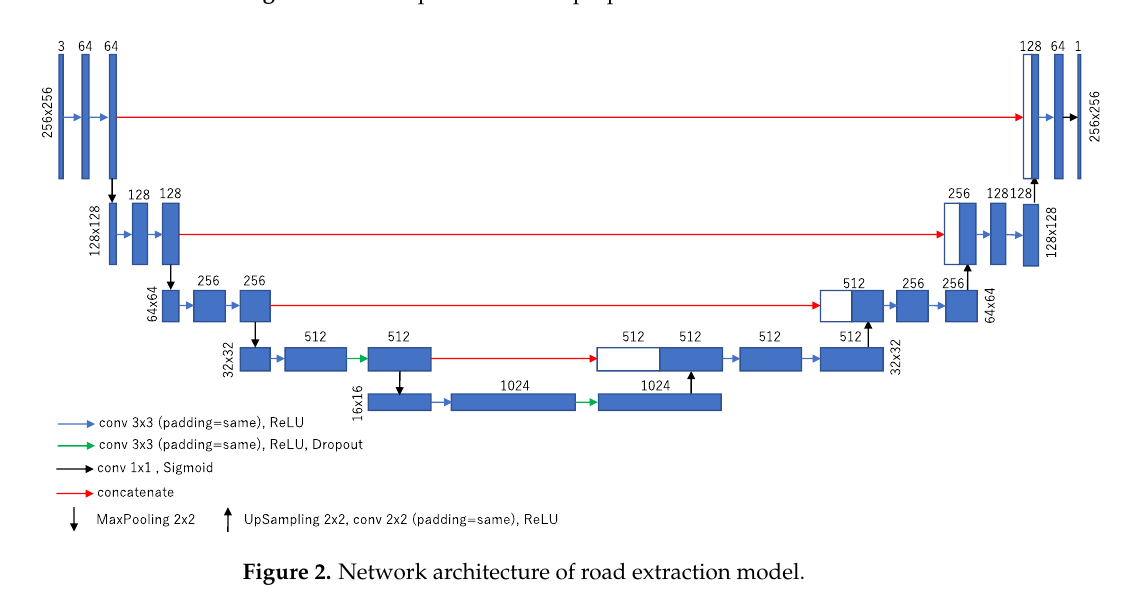
Figure 2. Network architecture of road extraction model.